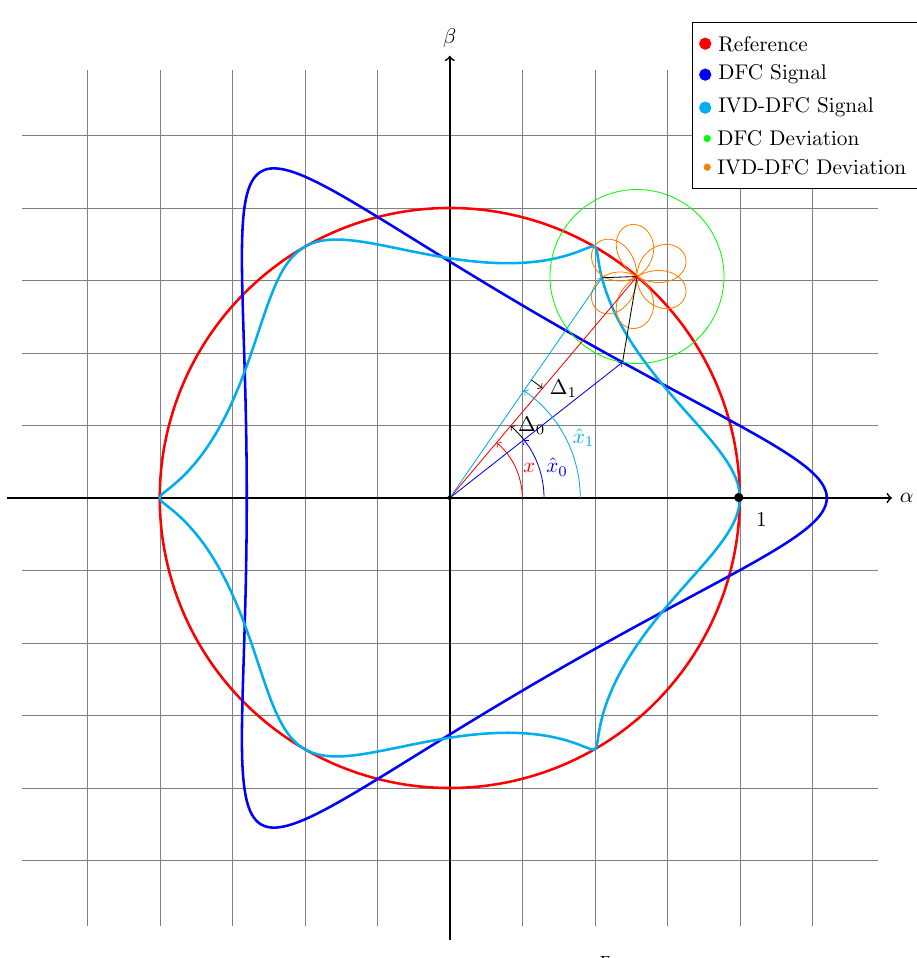
Figure 7. Plain representation of the DFC signals: axis (blue line). The red circle represents the signals for the case b = 0 and is taken as reference. The green circle with radius p represents the second harmonic. The light blue line represents the α and β signals obtained from the IVD-DFC algorithm. The orange line is the path taken by the new estimation error ∆ 1 , its maximal amplitude is smaller than p (case with p =